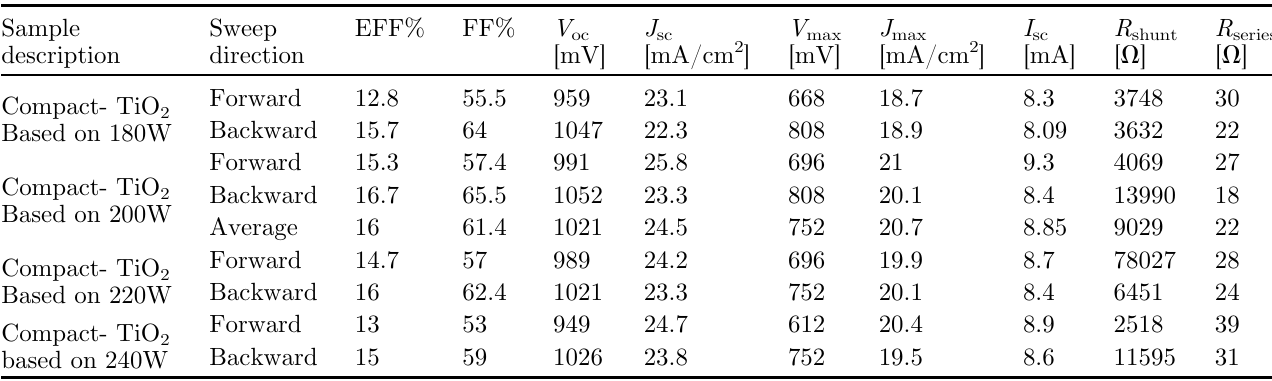
Table 4. Perovskite solar cell key parameters measured for C-TiO (12 sccm). Where an averaged ef fi ciency of 16% was obtained at 200 Ar (6 sccm) and O 2